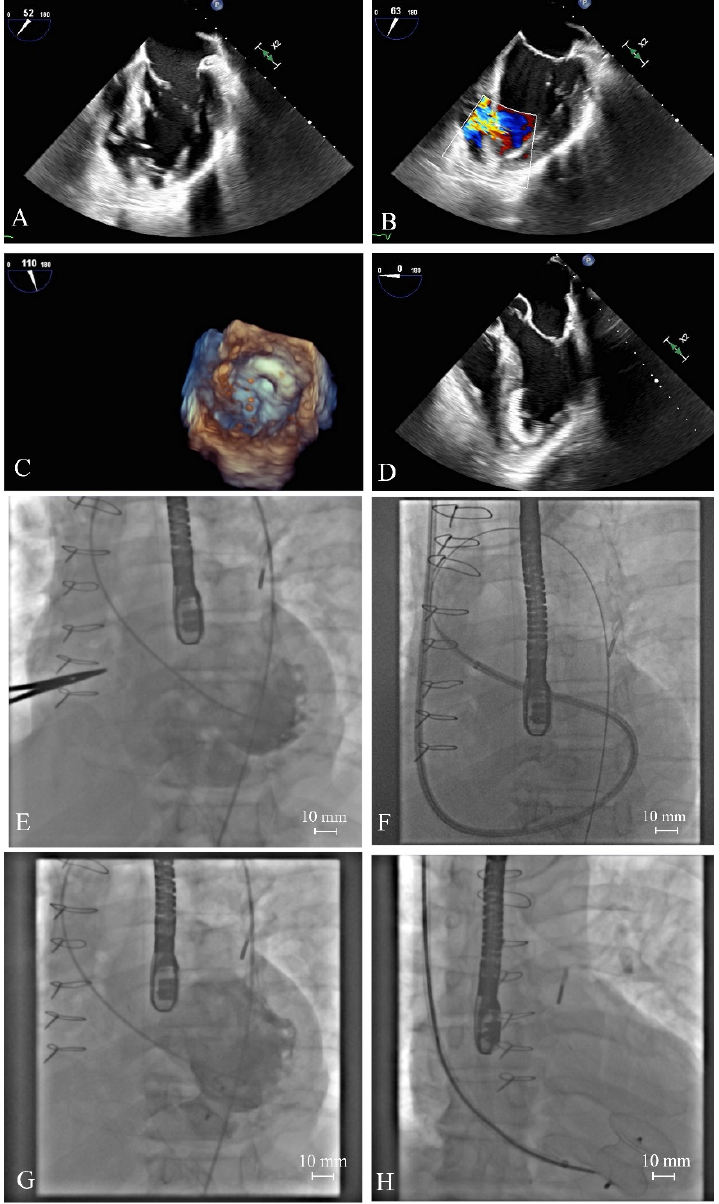
Figure 5. A patient with recanalized ventricular septal rupture initially treated with cardiac surgery. Ventricular septal rupture in transesophageal echocardiography ( A , B ) and LV angiography ( E ) treated with the Amplatzer occluder, inserted via the arteriovenous loop ( F , G ) with a nice effect ( D , H ). The LV surface of the Amplatzer occluder ( C ). LV: left ventricular.